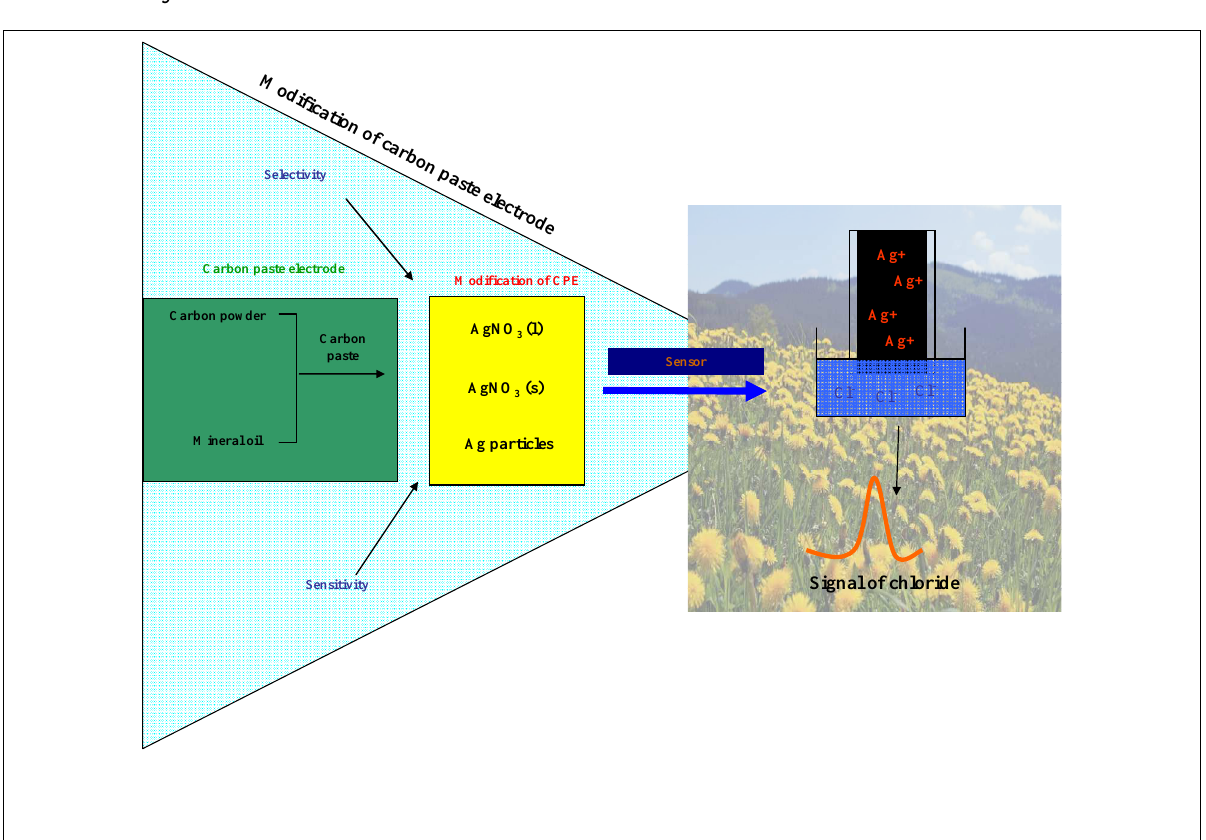
Figure 1. Chloride ion sensor. Sensor is based on modification of a carbon paste electrode with silver (I). Reaction between silver (I) and chloride ions provides high selectivity and sensitivity for detection of